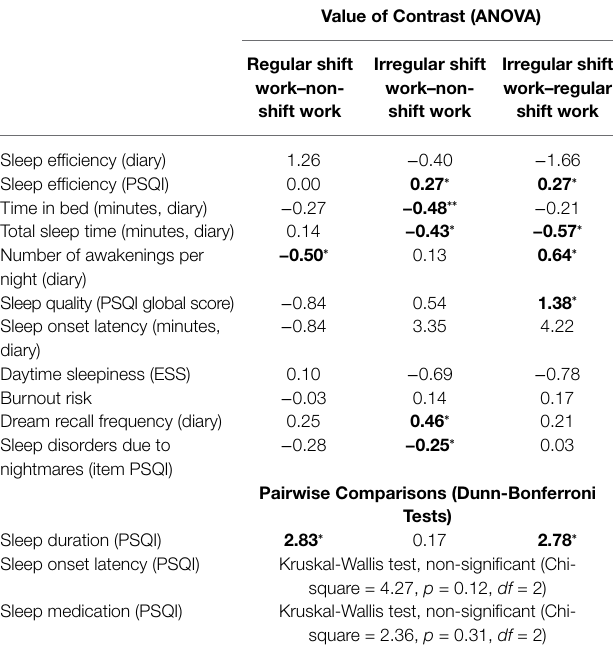
TABLE 4 | Pairwise comparisons between non-shift workers, regular shift workers, and irregular shift workers (ANOVA contrast tests for metrically scaled variables, respectively, Kruskal-Wallis tests and Dunn-Bonferroni tests for ordinally scaled